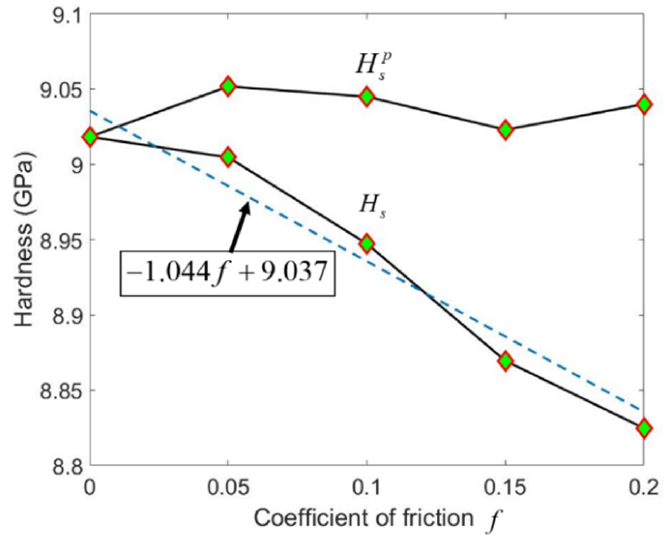
Figure 11. The hardness during scratching as a function of adhesion friction coefficient f for scratching with a 70.3° conical indenter. The value pairs of ( H s , f ) is fitted to obtain the dash line.